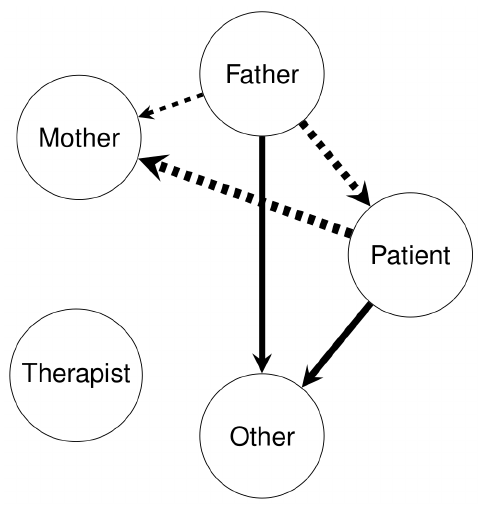
Figure 4. Graphical representation of changes in affiliative behaviour in conflictual communication during family therapy between initial and final session. Dashed line: decrease of behaviour; continuous line: increase of behaviour. Thickness of the arcs are proportional to the value of the changes.